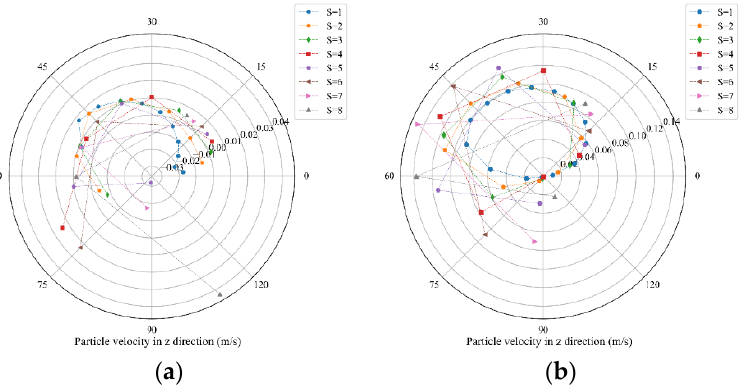
Figure 21. Particle velocity in Z direction. ( a ) Flat surface; ( b ) Convex pattern surface.